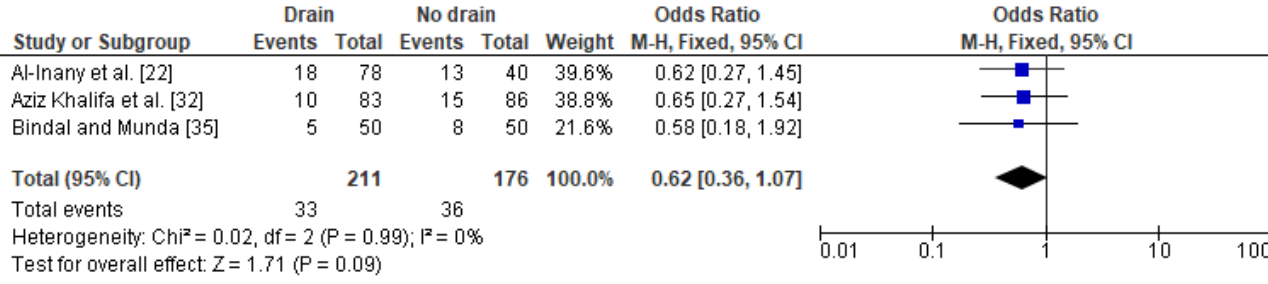
Figure 5. Forest plot for fever in the group of post-caesarean obese women with a drain and in the group of obese women without a drain. M.-H.—Mantel-Haenszel; CI—confidence interval; I 2 —heterogeneity; df—degrees of freedom.